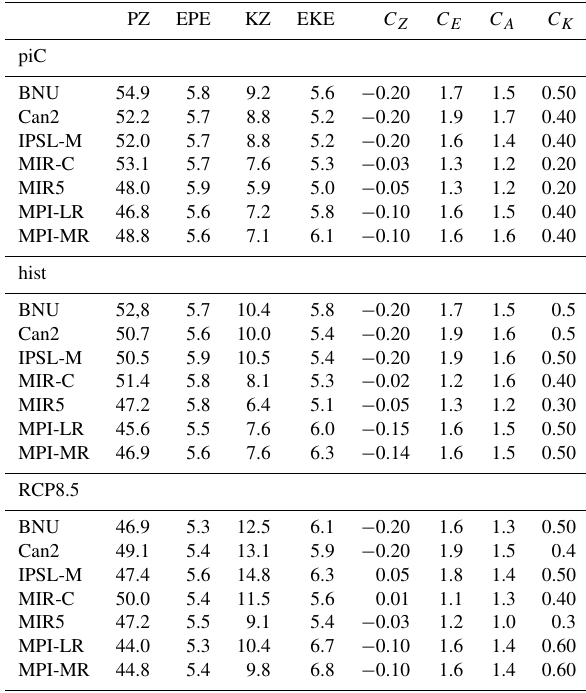
Table 7. Annual mean values of APE and KE reservoirs and con- version terms in the LEC (reservoir values: 10 5 Jm − 2 , conversion terms: Wm − 2 ). For the notation, refer to Appendix A1.